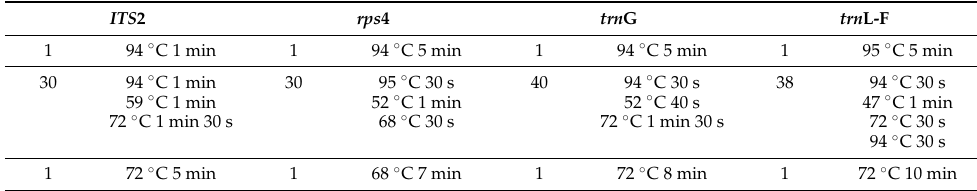
Table 5. PCR amplification protocols. Cycles are displayed in the first column of each region, heat and time in the